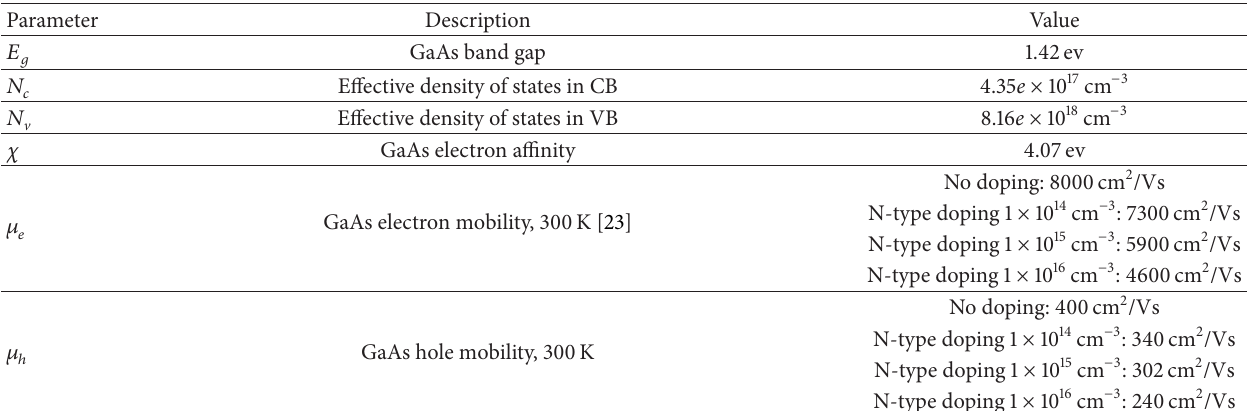
Table 1: Simulation parameters for graphene GaAs solar cell.